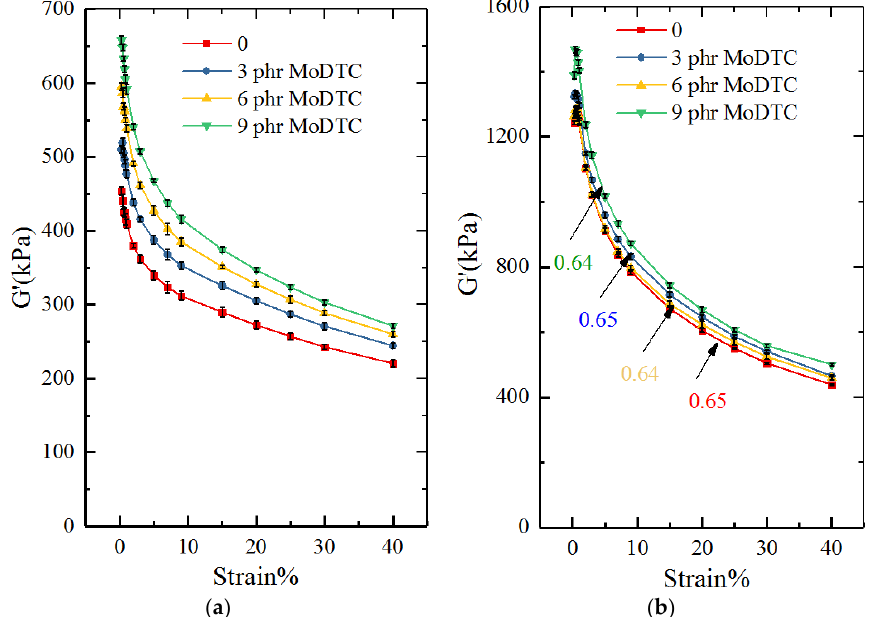
Figure 6. The Payne effect and silane coupling reaction degree of the RPA test. ( a ) Payne effect and ( b ) silane coupling reaction.